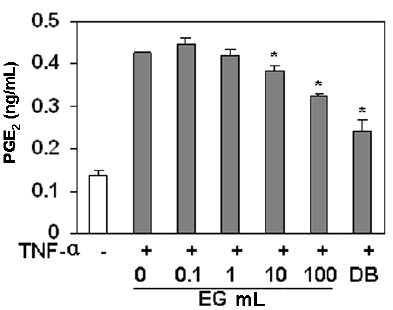
Cells were cultured with indicated EG and 1 µg/mL DB for three days in the presence of 10-10 M TNF- α . PGE2 concentration was measured by ELISA. Results were expressed as means ± S.D. of five determinations. * P < 0.05, ** P < 0.01 compared with control by student t -test. “EG” means emodin-8- O - β - D